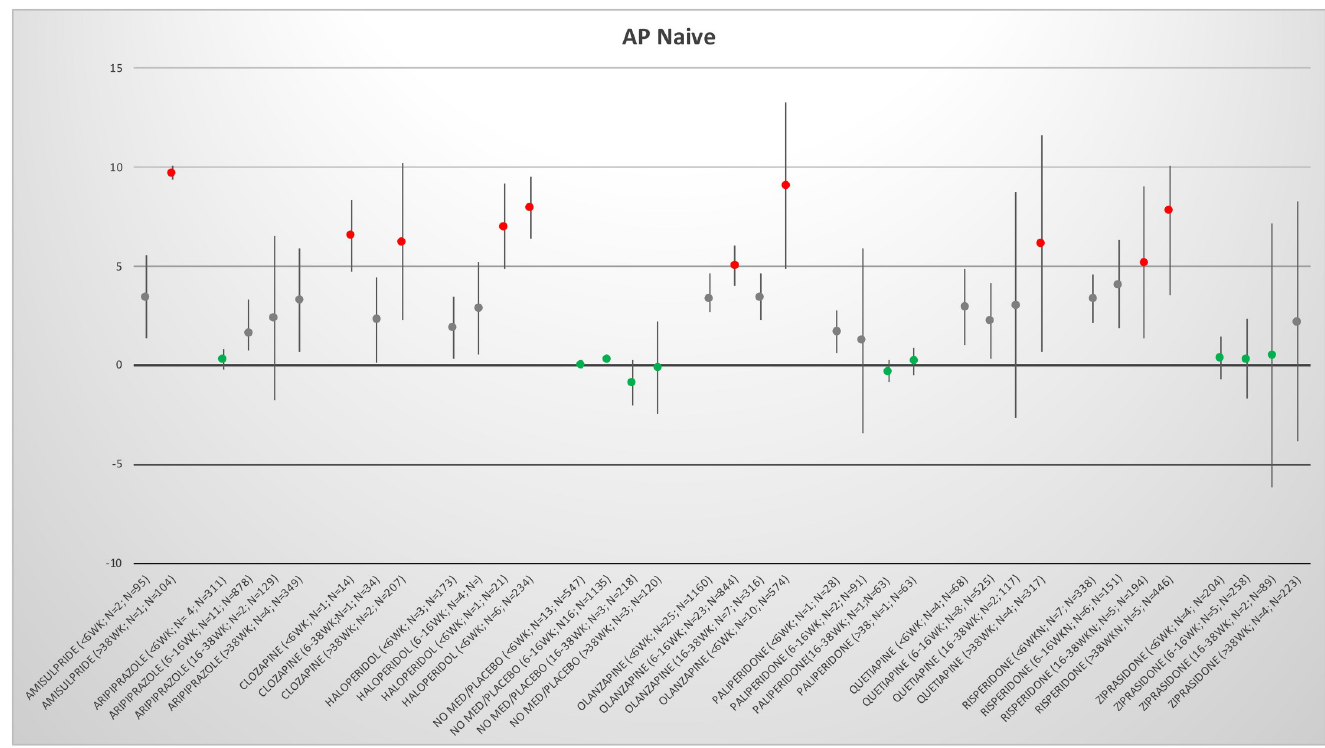
Fig 2. Mean change in body weight per AP per period of the AP-naive group. The antipsychotics per period. Green indicates almost no weight gain or weight loss. Grey indicates weight increase between 1 and 5 kilograms and red indicates weight increase > 5 kilograms per period. After the antipsychotic between brackets is indicated period in weeks, number of studies (N) and number of patients (n) were